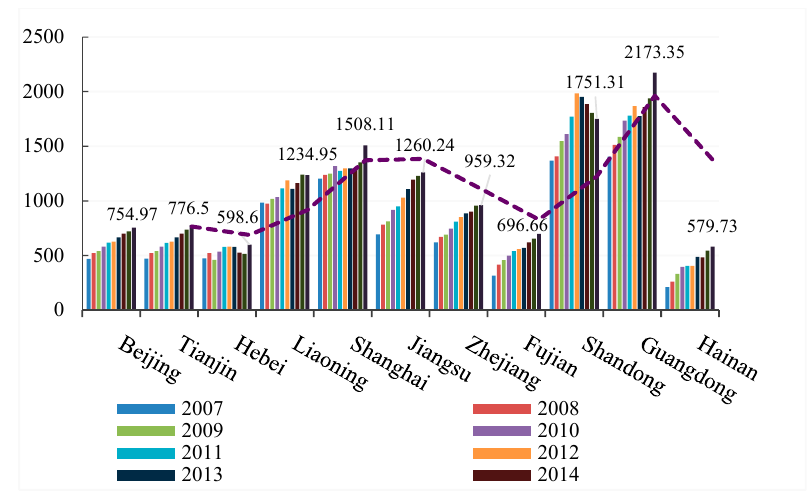
Figure 2. Transportation carbon emissions in the eastern region (2007–2016).